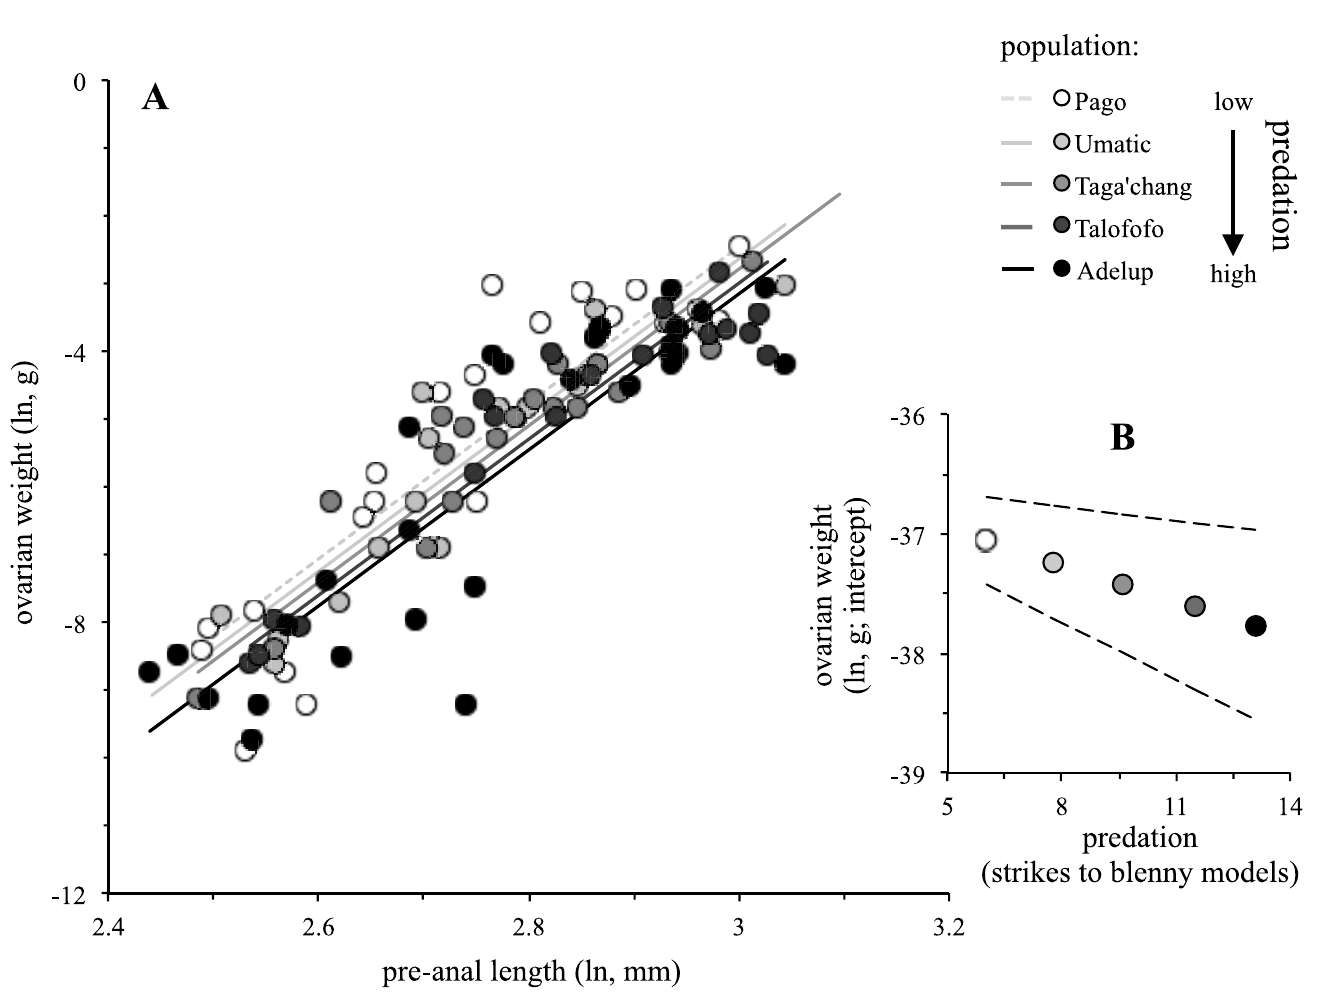
Fig 3. Variation among populations in reproductive investment as a function of predation ( A ). Also shown ( B ) are population coefficients computed using the best-supported model for predation reported in Table 1. The dashed lines around coefficients are the upper and lower 95% confidence interval of the computed trend between reproduction and predation. Symbols are shaded according to the level of predation, from white (low predation) to black (high